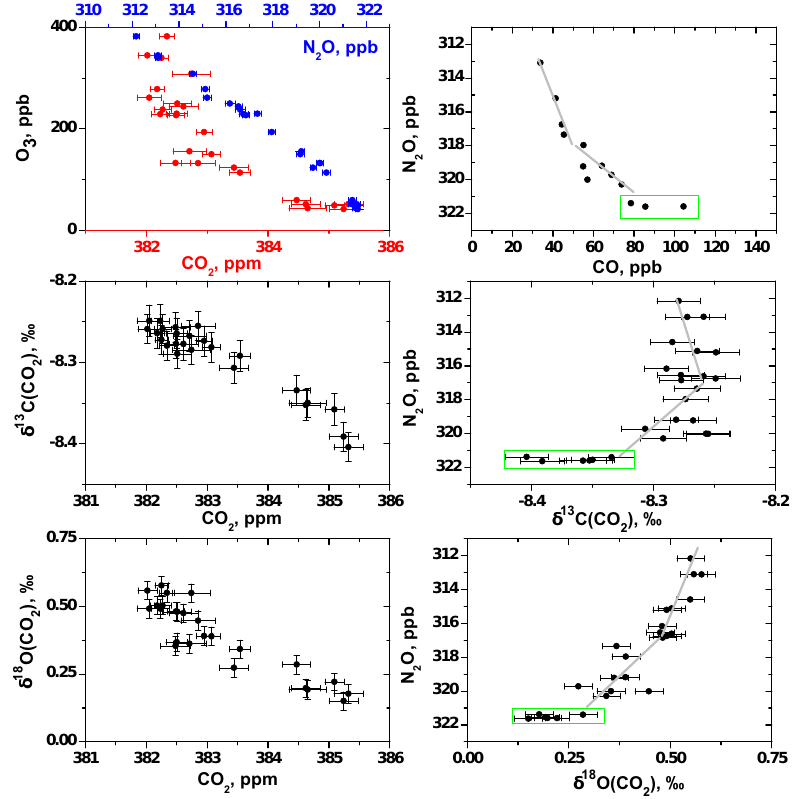
Fig. 5. Flight Frankfurt-Denver-Frankfurt (17–18 December 2007, latitudes 41 to 63 ◦ N) crossing the tropopause and demonstrating anti- correlations between O 3 , CO and GHG data. The N 2 O vs. CO 2 isotope data demonstrate the same compact curvilinear mixing relationship (due to UT/LMS mixing) as typically recorded by O 3 and CO. The CO 2 isotope data plotted vs. CO 2 give linear mixing trends. The correlation between isotope data and stratospheric tracers (N 2 O and O 3 ) is observed for majority of flights that crossed the UT/LMS mixing. Data in the green boxes show UT